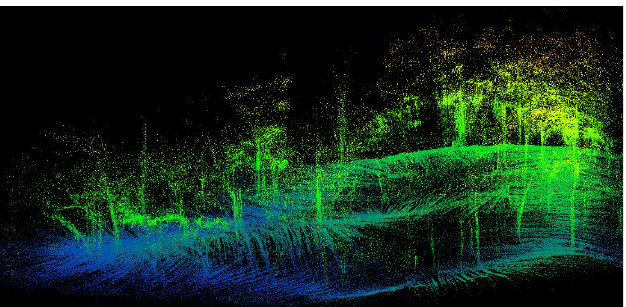
Figure 6. The 3D forest point cloud map of a complex scene.